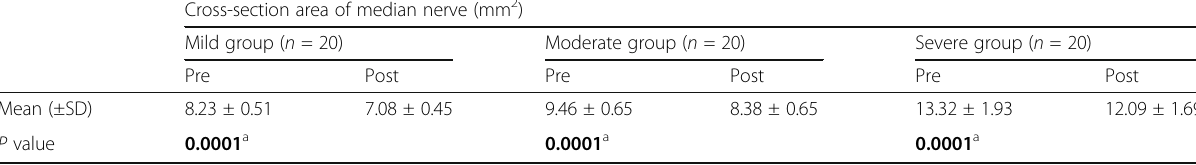
Table 4 Comparison between pre- and post-cross-section area of median nerve within mild, moderate, and severe groups Cross-section area of median nerve (mm 2